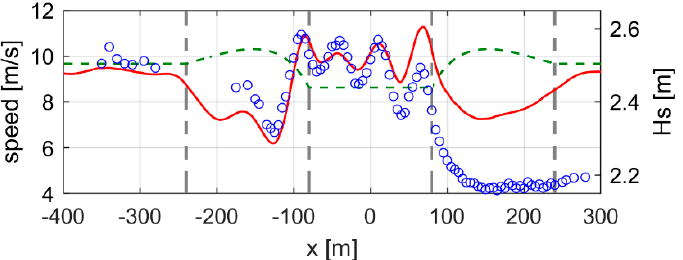
Figure 9. The theoretical linear group speed of the waves H2.5T11 (green dashed, axis at left), with the value of Hs (axis right) inserted over the area for the 1D long-crested simulation (red solid) and the experimental data (blue circle).